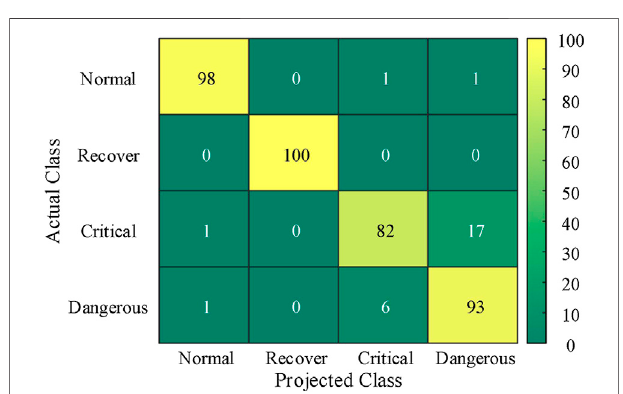
FIGURE 7 | Projection results of LSTM.